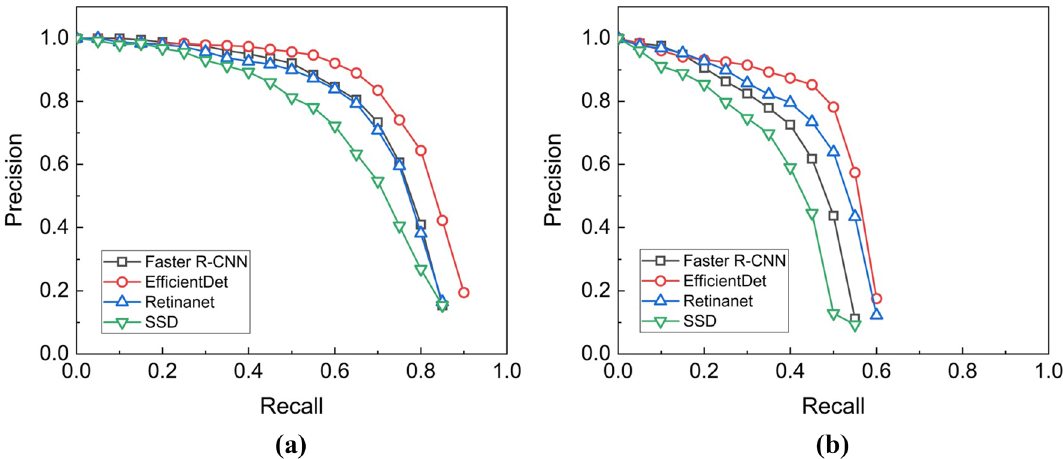
Figure 2. Precision-recall (PR) curve of models: ( a ) IOU: 0.5; ( b ) IOU: 0.75.